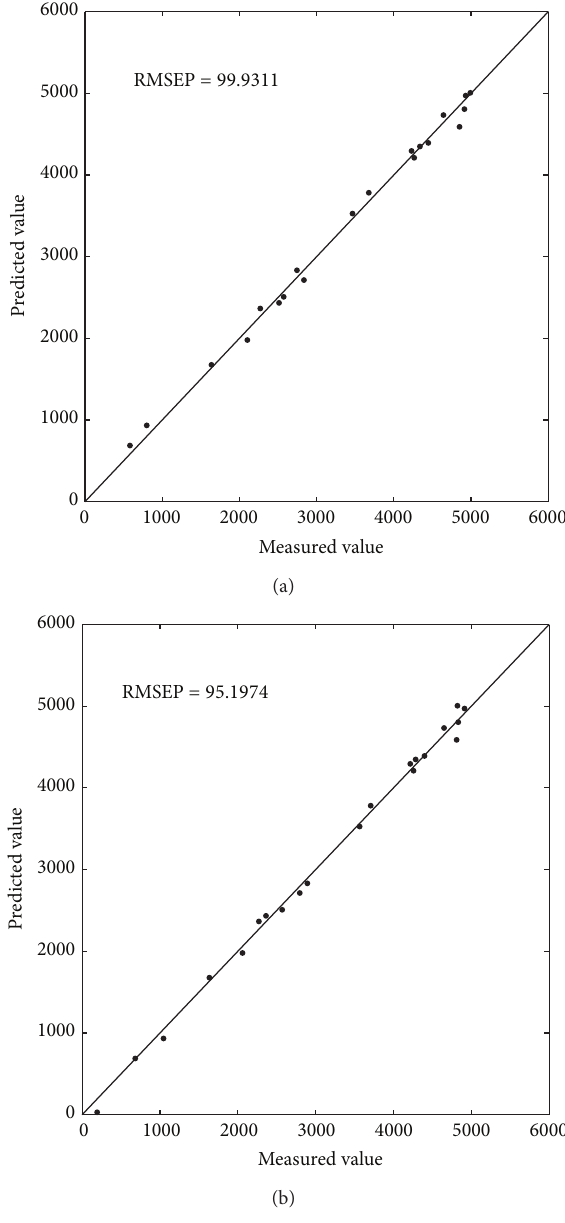
Figure 2: Prediction value versus measured value scatter diagram of different methods for CH 4 . (a) PLS; (b) RBFEI-PLS.